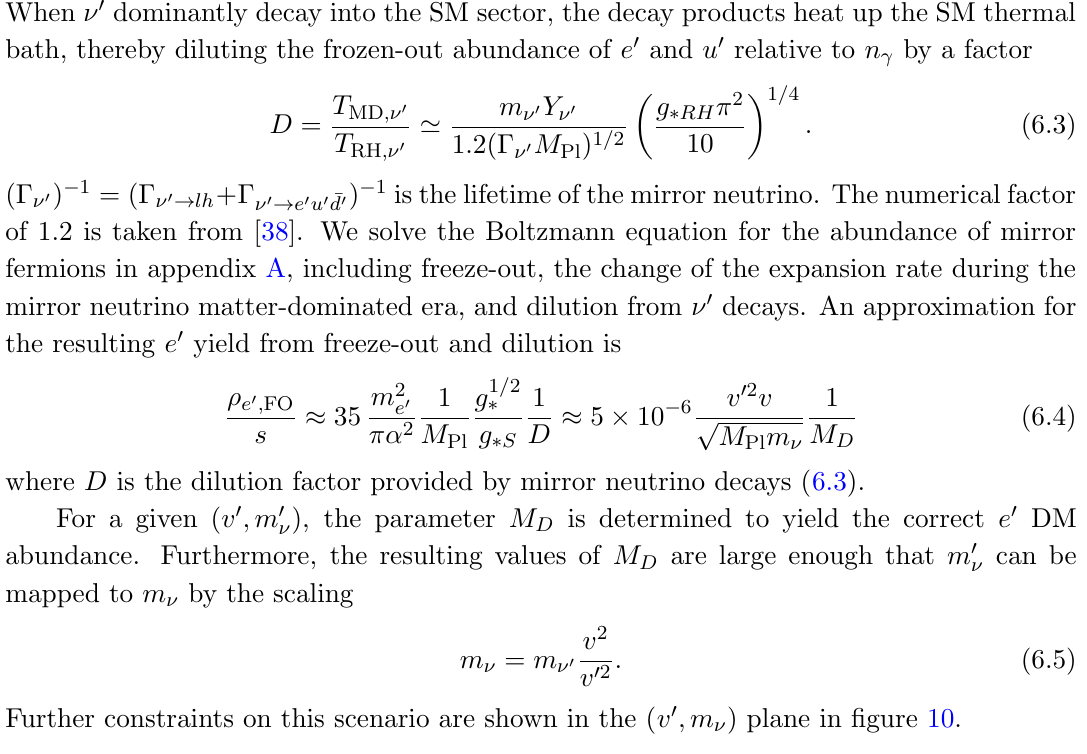
Figure 10 . Constraints on ( v 0 ; m (cid:23) ) when e 0 dark matter arises from freeze-out and dilution from one long-lived species of (cid:23) 0 . Here m (cid:23) is the mass of the neutrino that is the Higgs Parity partner of the long-lived (cid:23) 0 . Purple contours show (cid:1) N e(cid:11) resulting from decays of S 0 to (cid:13) 0 . Vertical gray contours show v 0 when m t and (cid:11) S ( m Z ) deviate from their central values by 0 to 3 (cid:27) . When (cid:23) 0 dominantly decay into the SM sector, the decay products heat up the SM